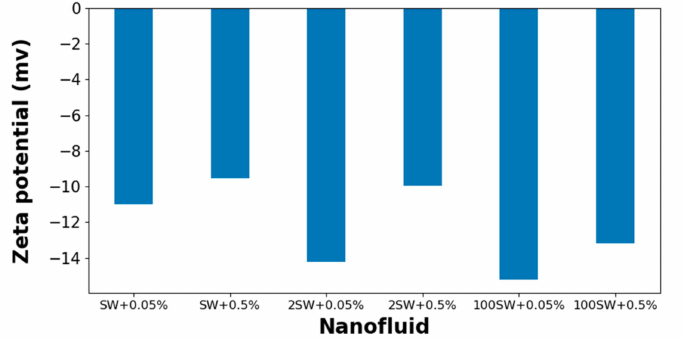
Figure 7. Changes of zeta potential between nanofluids with different salinities and